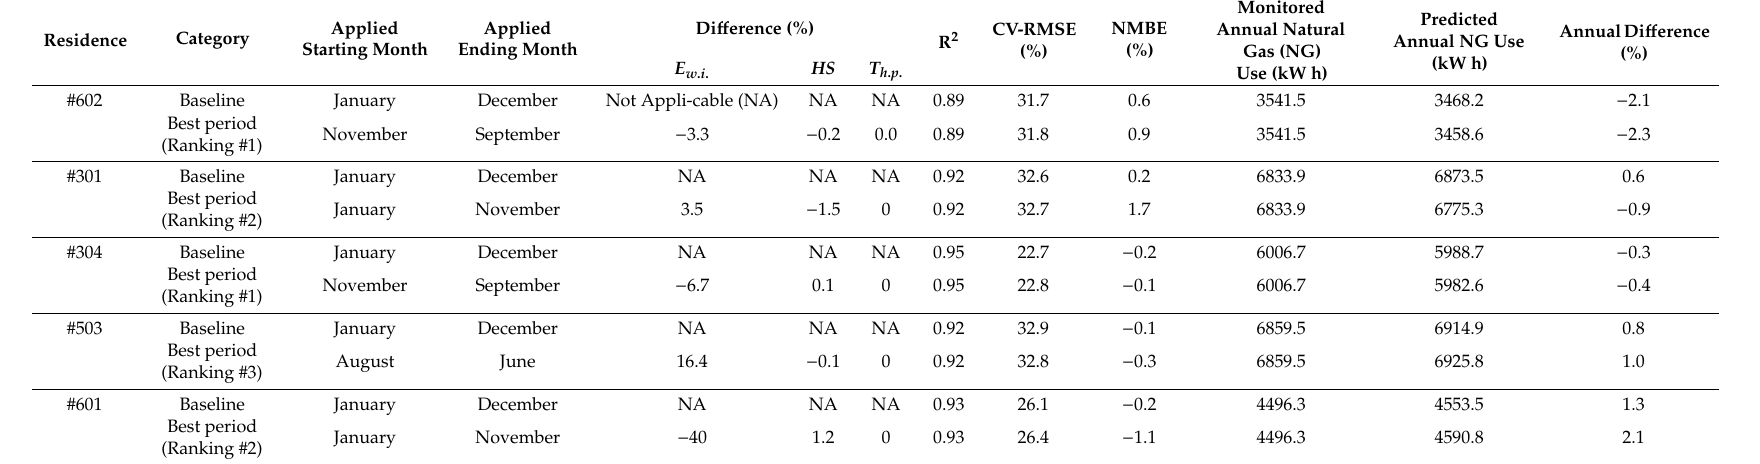
Table 9. Results from the annual prediction